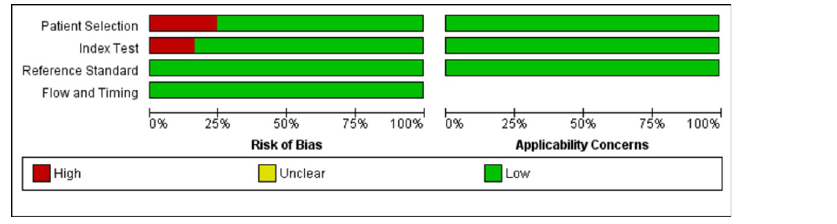
Fig 8. Overall percentage of risk of bias and applicability concern using the QUADAS-2 tool.